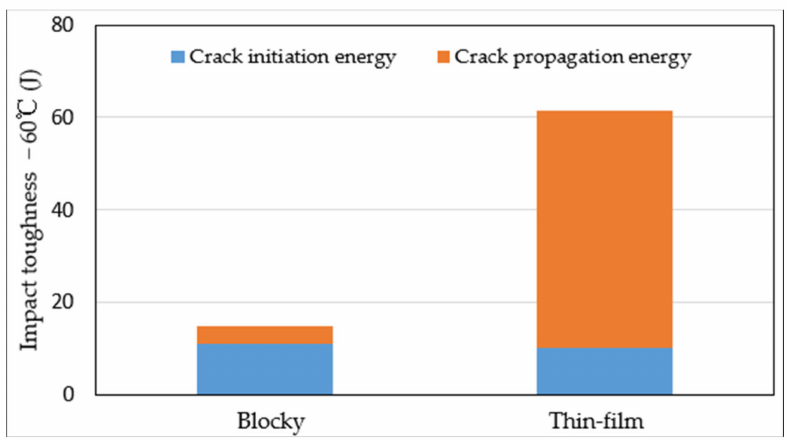
Figure 12. Comparison of fracture